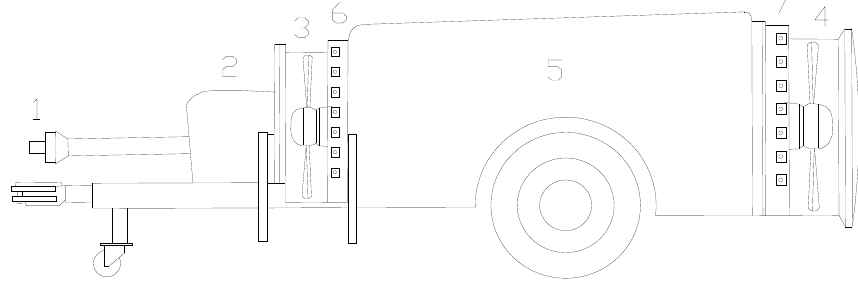
Figure 1. Air-assisted sprayer equipped with two reversed-rotation axial fans. 1. PTO;